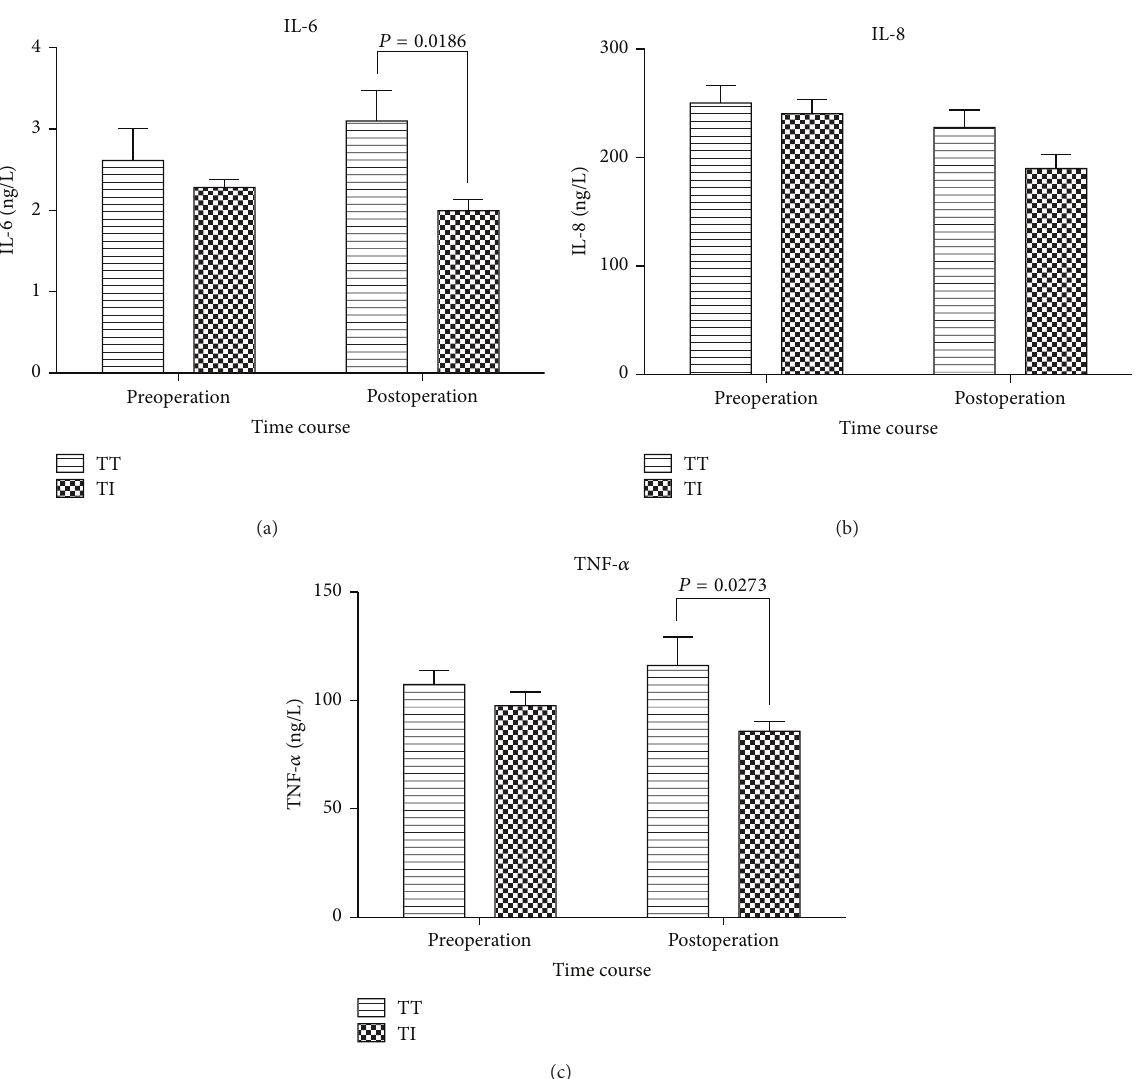
Figure 5: Changes in plasma IL-6, IL-8 and TNF- 𝛼 concentration in Group TT and Group TI. Values are given as Mean ± SEM. Group TT, tracheal tube intubation group; Group TI, I-gel facilitated endotracheal tube intubation